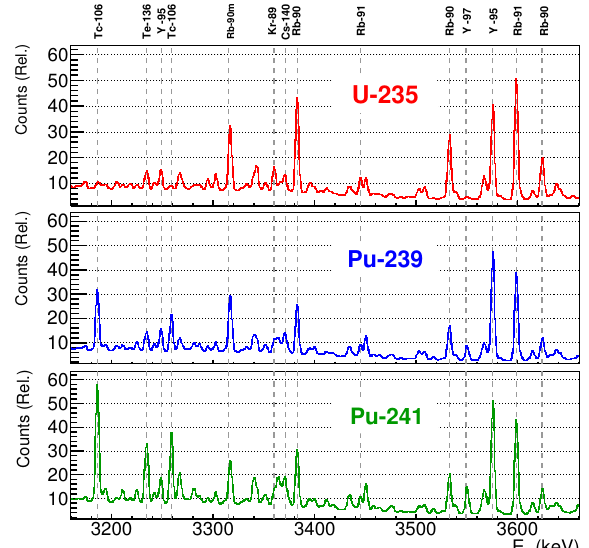
Figure 2: Comparison of noted simulated fissile nuclide high-energy gamma-ray spectra collected with an interro- gation of 50-s irradiation, 150-s measurement, 5-s delay and reset, and 13